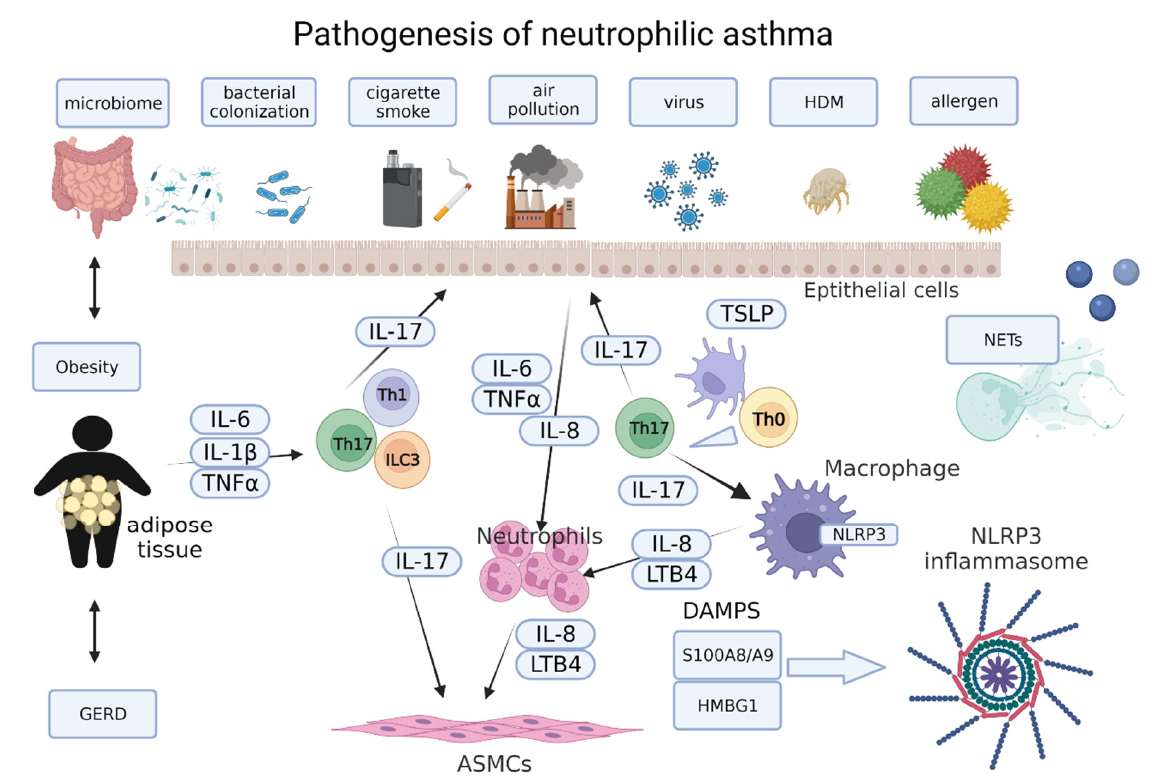
Figure 1. Pathogenesis of neutrophilic asthma. Several cells, including airway epithelial cells, macrophages, T helper (Th) cells, innate helper 3 cells (ILC3), airway smooth muscle cells (ASMCs), and neutrophils play important roles in the pathogenesis of neutrophilic asthma. Airway epithelial cells, stimulated by air pollution, cigarette smoke, bacterial colonization, virus, and allergens, secrete TSLP, IL-33, and IL-25. TSLP secreted from epithelial cells and inflammatory cells converts Th0 to Th17 cells and subsequently induced neutrophil recruitment via IL-8 and GM-CSF, induced by IL-17 from airway epithelial cells. The IL-17/Th17 axis is involved in bacterial colonization and microbiome associated neutrophilic inflammation in asthma. Obesity and GERD are related to severe, neutrophilic asthma and the IL-17/Th17 axis is involved in these conditions. Neutrophil extracellular trap (NETs) formation, damage-associated molecular patterns (DAMPs), and NLPR3 inflammasome are also involved in the pathogenesis of neutrophil asthma.